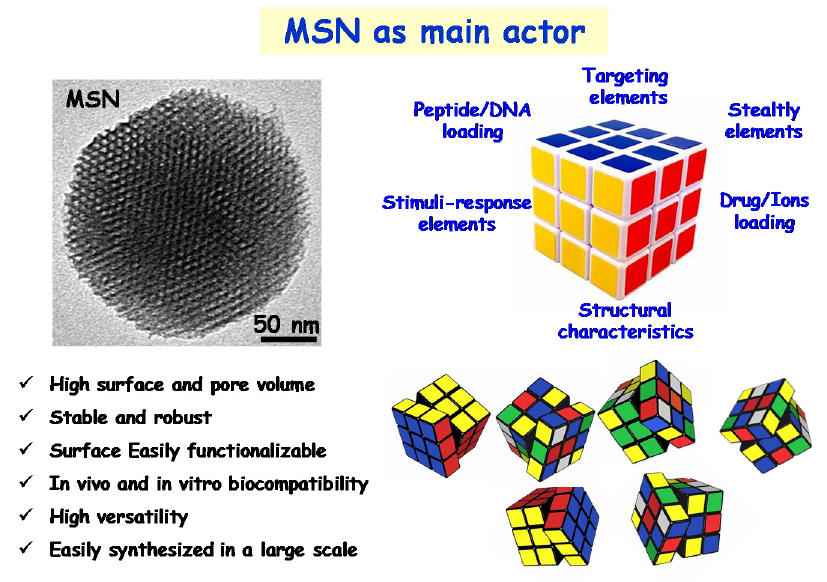
Figure 5. Role of MSN as one of the main actors in the design and development of a nanoantibiotic for infection treatment. Left: TEM image of a MSN and its main features as an ideal nanocarrier of antimicrobial agents. Right: illustrative simile between a MSN and a Rubik’s cube to emphasize the different facets that can be adapted to design nanoantibiotics for future personalized therapies.